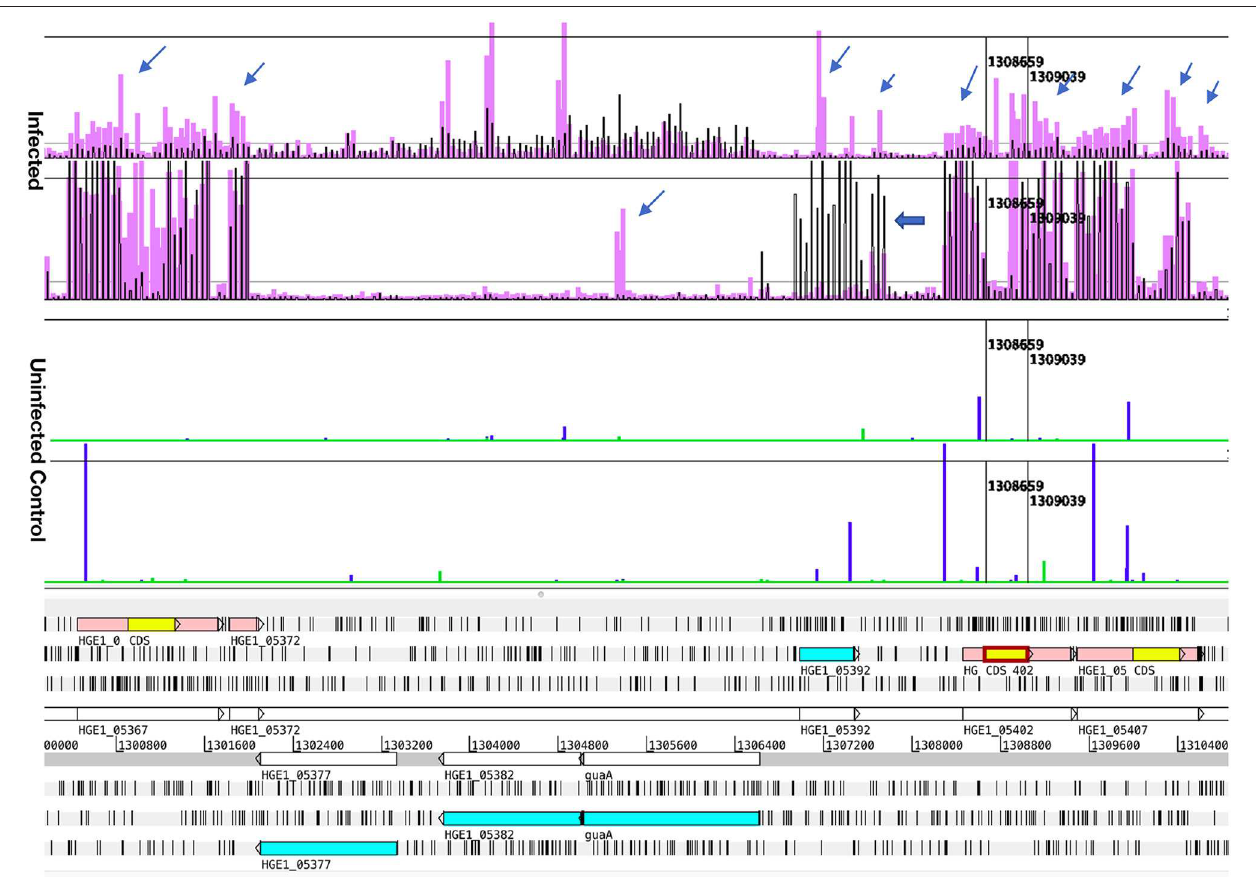
FIGURE 3 | Comparison of transcript signal from Samples 1 and 3, illustrating antisense transcripts and transcription from an unannotated gene. Transcription data (top four graphs) plotted over the annotated genome sequence (sections at the bottom; turquoise boxes denote coding regions of annotated genes, pink boxes denote p44 conserved sequences with yellow boxes denoting their center hypervariable region) of A. phagocytophilum (Ap) strain HGE1 using the Artemis genome browser. The top two graphs (Infected) represent Ap transcription in Sample 1 (black bars, 2h with HL-60 cells) vs. in Sample 3 (lavender bars, 2h with ISE6 cells). Each vertical bar corresponds to one 60-mer probe on the tiling array. The two graphs below (Uninfected control) are plots of data from uninfected cells (HL-60, green; ISE6, blue), to demonstrate that host cell transcripts are not responsible for antisense signals. Occasional probes produce signals but overall the sterile cell graphs are flat. Prominent antisense signals generated by Ap from ISE6 are indicated by slender arrows, including those associated with the p44 conserved regions (pink boxes). Also shown is a p44 paralog (HGE_05367; at base position 1,300,800 in the genome) specifically transcribed in Sample 3, as indicated by signal corresponding to the center hypervariable region (yellow box). Note a hypothetical gene, HGE1_05392, with elevated transcript levels in Sample 1 (and with antisense signals in Sample 3). Immediately downstream, a transcription peak indicates the presence of a small, unannotated gene (bold arrow). Transcription levels from the HVRs of p44 s HGE_05367, HGE1_05402, and 05407 were rated 1, 0, and 2 in HL-60, and 4, 0, and 1 in ISE6, respectively. Nucleotide positions in the genome are indicated by numbers above the gray